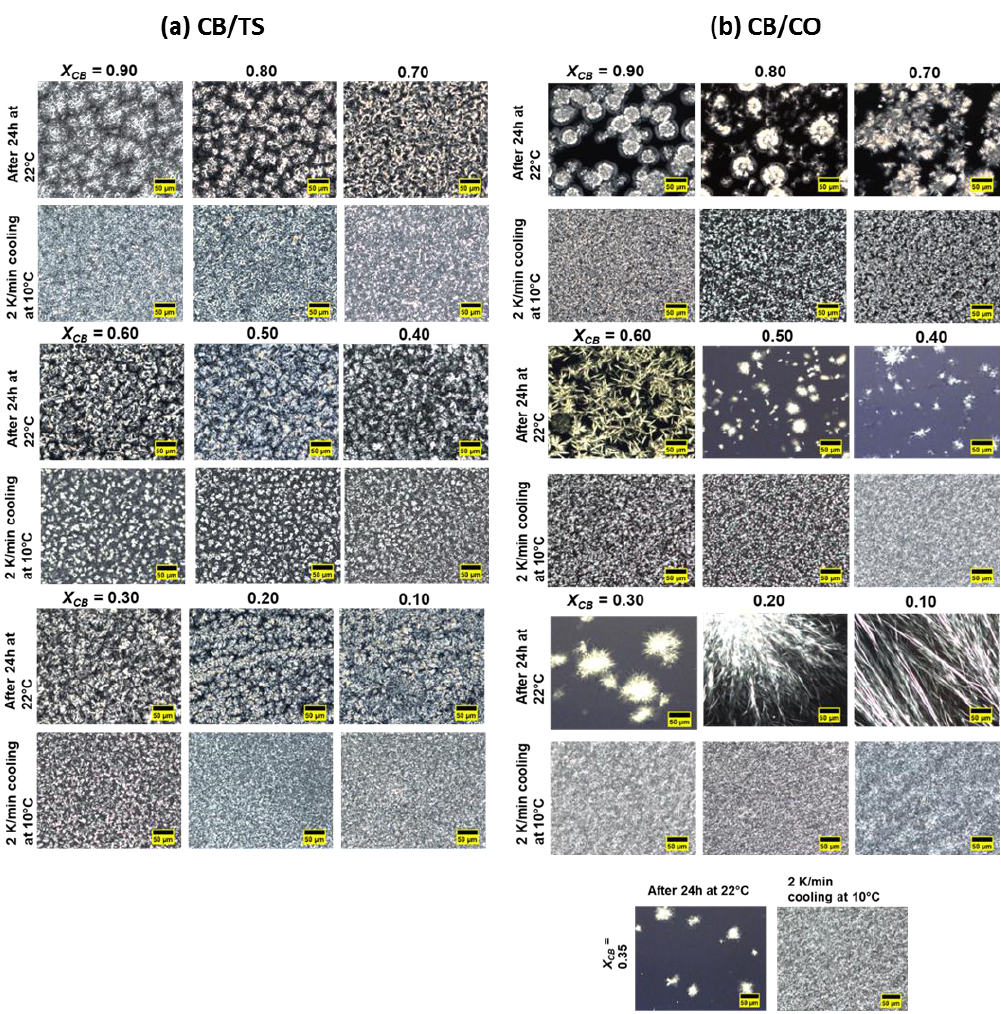
Figure 9. PLM analysis of ( a ) CB/TS blends, and ( b ) CB/CO blends after crystallizing isothermally at 22 °C for 24 h and then heating the sample to 90 °C and cooled down to 10 °C with 2 K/min rate for studying the effect of dynamic crystallization. Scale bar = 50 µm.